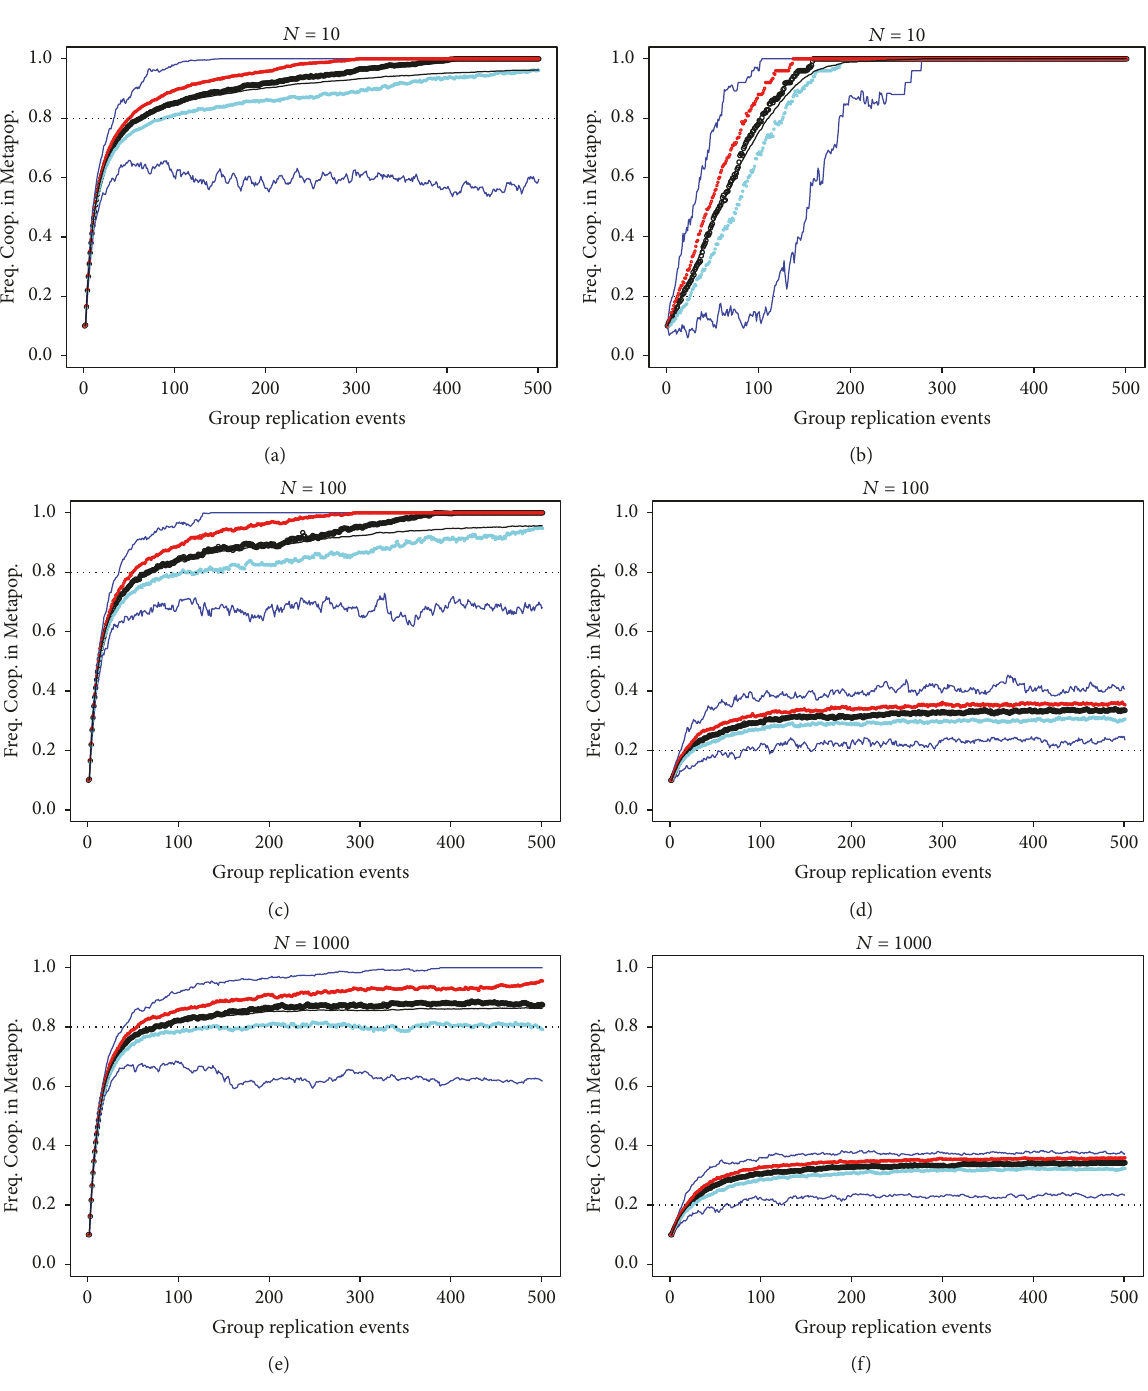
Figure 7: Two-level Moran model with variation in r-values. Each panel represents simulation results for our model when groups in the metapopulation vary in their initial 𝑟 -values. The panels (a, e, c) show the results for 𝑟 = .33 , while the panels (b, d, f) show 𝑟 = 0.89 . Each panel represents summary results for 100 independent simulations with populations of 10 (a, b), 100 (c, d), and 1000 (e, f) individuals. In each simulation, there were 25 groups with an initial cooperator frequency of .10, 500 group replication events, and 100 within-group generations. The red, black, and light blue (cyan) dots are the first, second, and third quartiles of the observed frequencies of cooperators in the metapopulation, respectively, while the thin black line is the mean frequency. The blue lines are the maximum and minimum observed frequency across 100 simulations. The dashed, horizontal line is the long-term, expected frequency of cooperation in the metapopulation assuming a null model given by (13). Note that the observed frequency of cooperators is greater than that predicted by the null models in all cases, sometimes